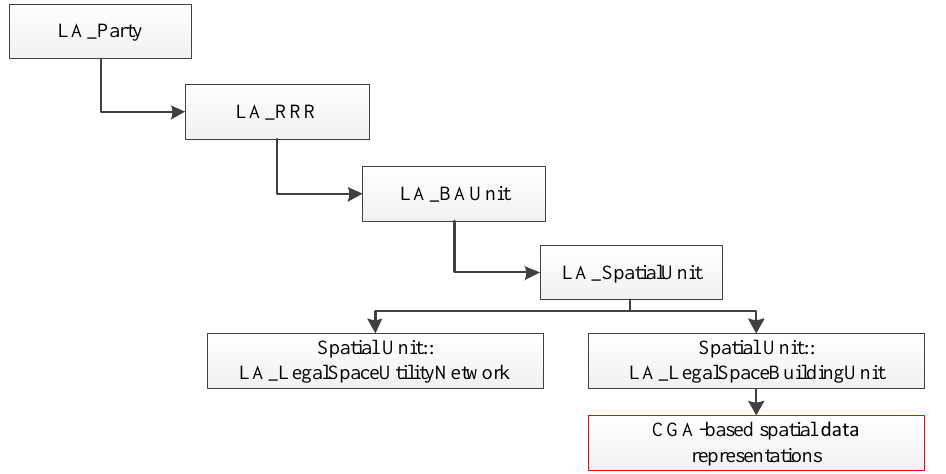
Figure 4. Relationship between a CGA-based data model and LADM (Land Administration Domain Model)